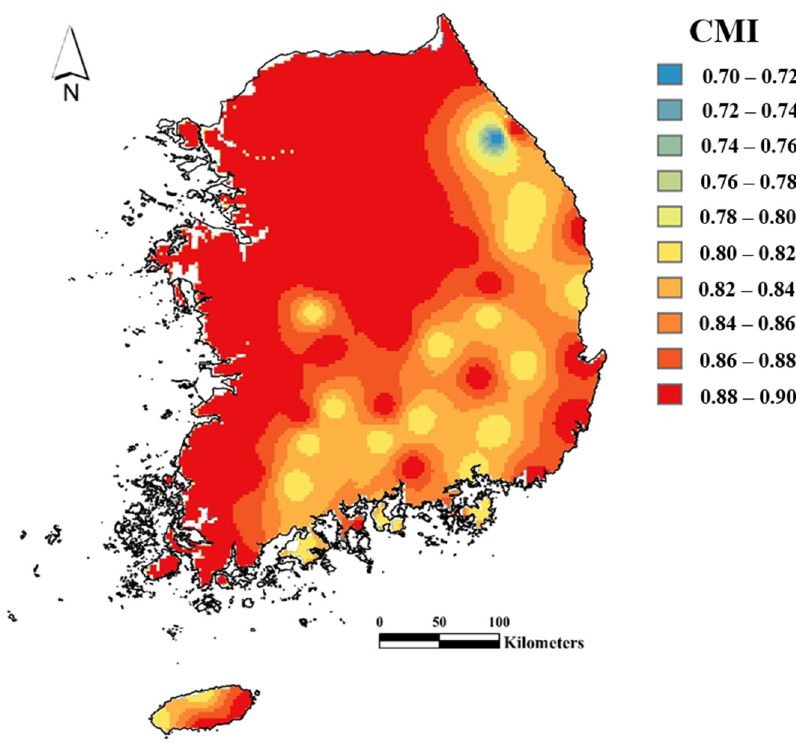
Figure 2. The climate similarity (i.e., the climate matching index (CMI) in CLIMEX) map in Korea compared to one of the most favorable climatic conditions for R. shantungensis populations: Zhejiang province in China. CMI > 0.5 indicates a suitable habitat for R. shantungensis .